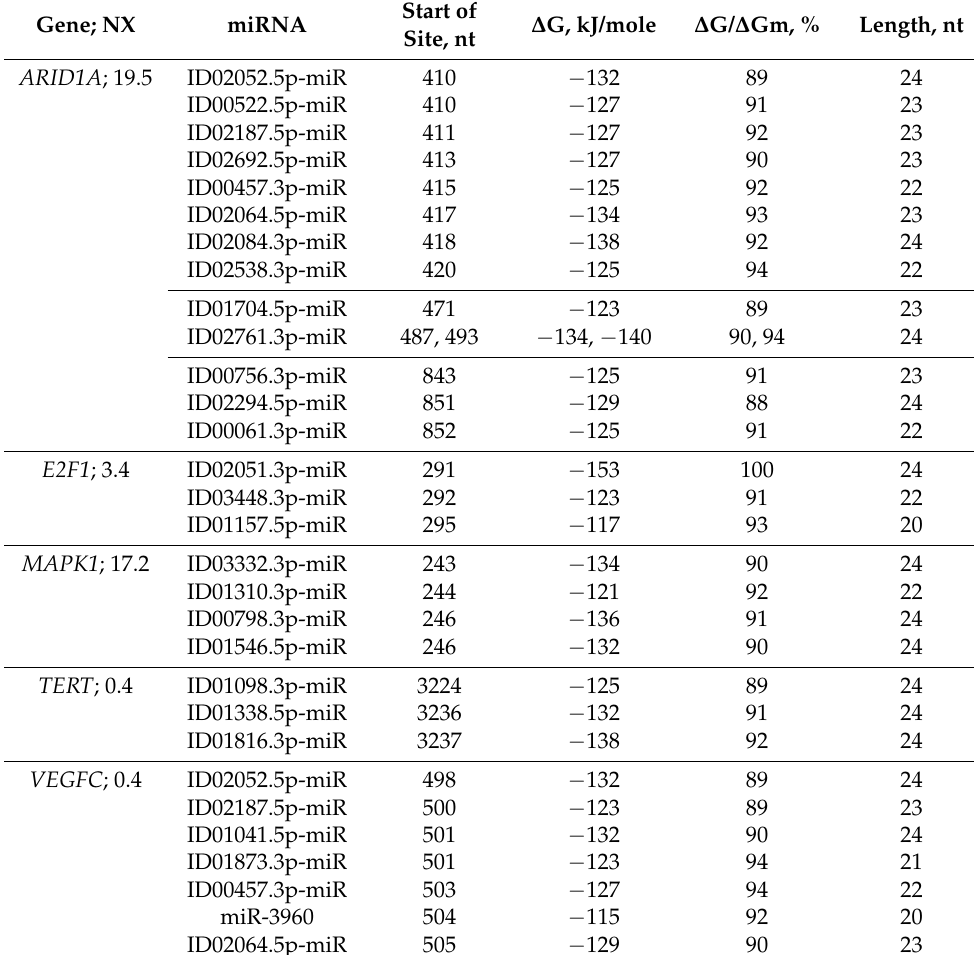
Start of ∆ G, kJ/mole ∆ G/ ∆ Gm, % Length, nt Site, nt